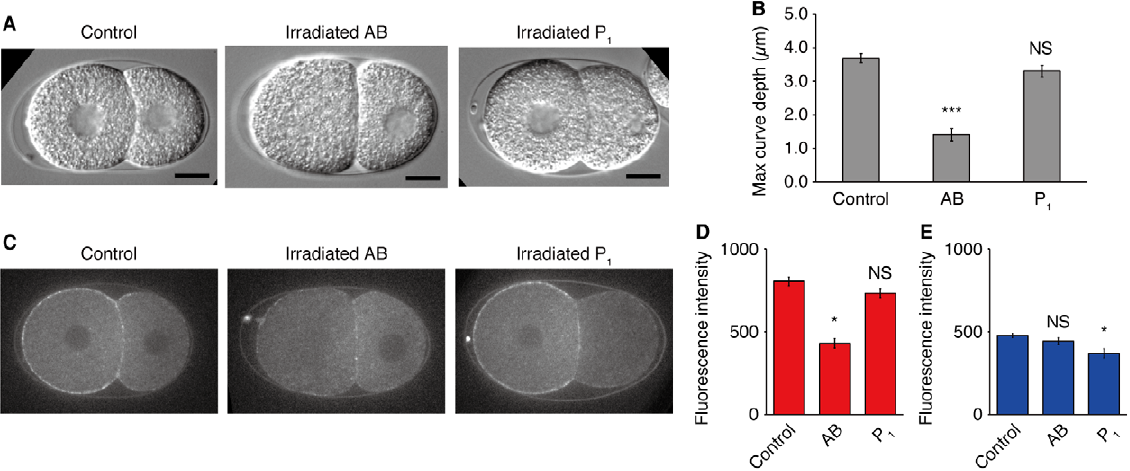
Figure 5. UV irradiation to the AB nucleus impairs curve formation. (A) DIC images of the embryos in which their nuclei were irradiated by a UV laser. The images were taken 8 min after the onset of the two-cell stage. Scale bars, 10 m m. (B) Maximum curve depth of the contact surfaces. AB, UV irradiation to the AB nucleus (n=10); P 1 , UV irradiation to the P 1 nucleus (n=10). (C) Embryos that expressed NMY-2::GFP and their nuclei were irradiated by UV. 8 min after the onset of the two-cell stage. (D and E) Fluorescence intensity at the cell cortex. Control, untreated embryos (n=6); AB, UV irradiation to the AB nucleus (n=7); P 1 , UV irradiation to the P 1 nucleus (n=5). (D) Cortex of AB cell. (E), Cortex of P 1 cell. Error bars indicate s.e.m. *, P , 0.01; ***, P , 0.0001; NS, non-significant ( P . 0.1); Mann–Whitney test.